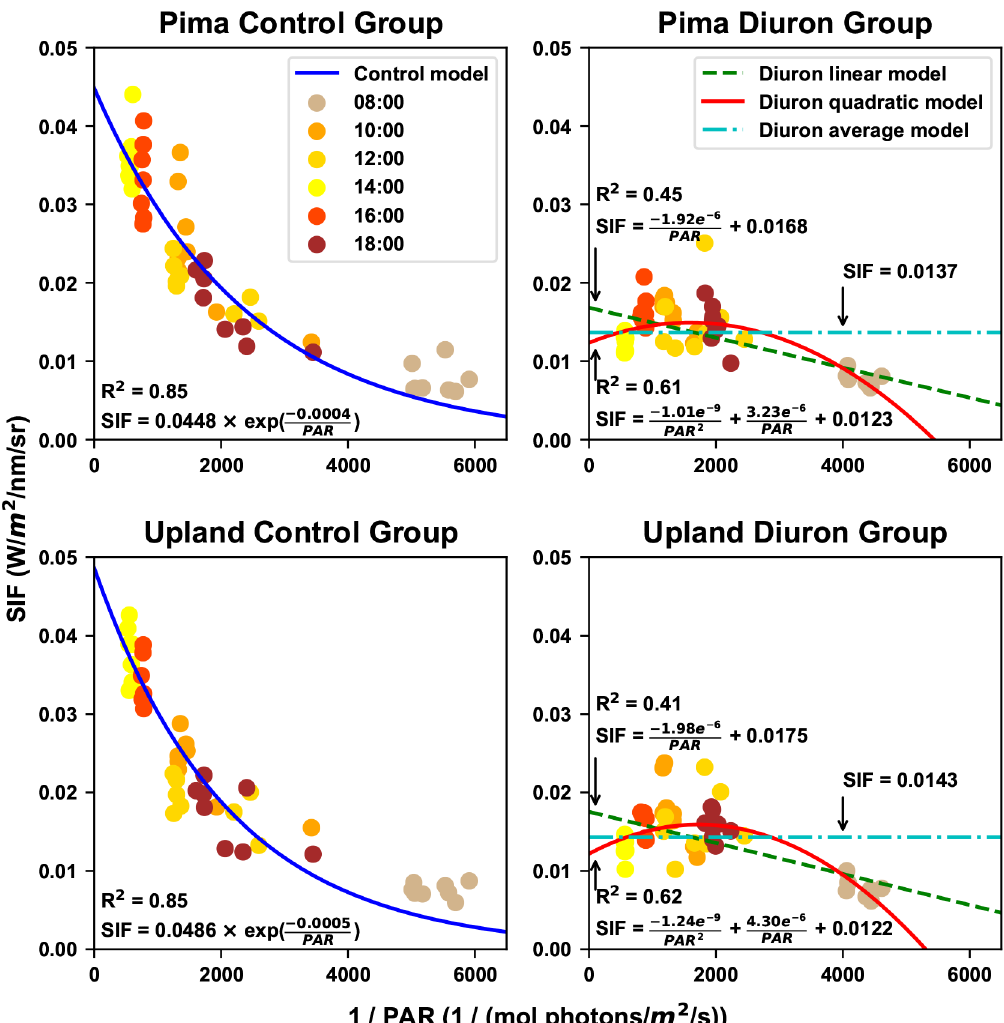
Figure 4. Estimation of maximal fluorescence values for control and Diuron treatments. An exponential model was used to fit the SIF and PAR reciprocal values for plots in the control group, whereas three models (linear, quadratic, and average) were used to fit the SIF and PAR reciprocal values for plots in the Diuron-treated group. The maximal fluorescence value was defined as the value when the PAR reciprocal equaled